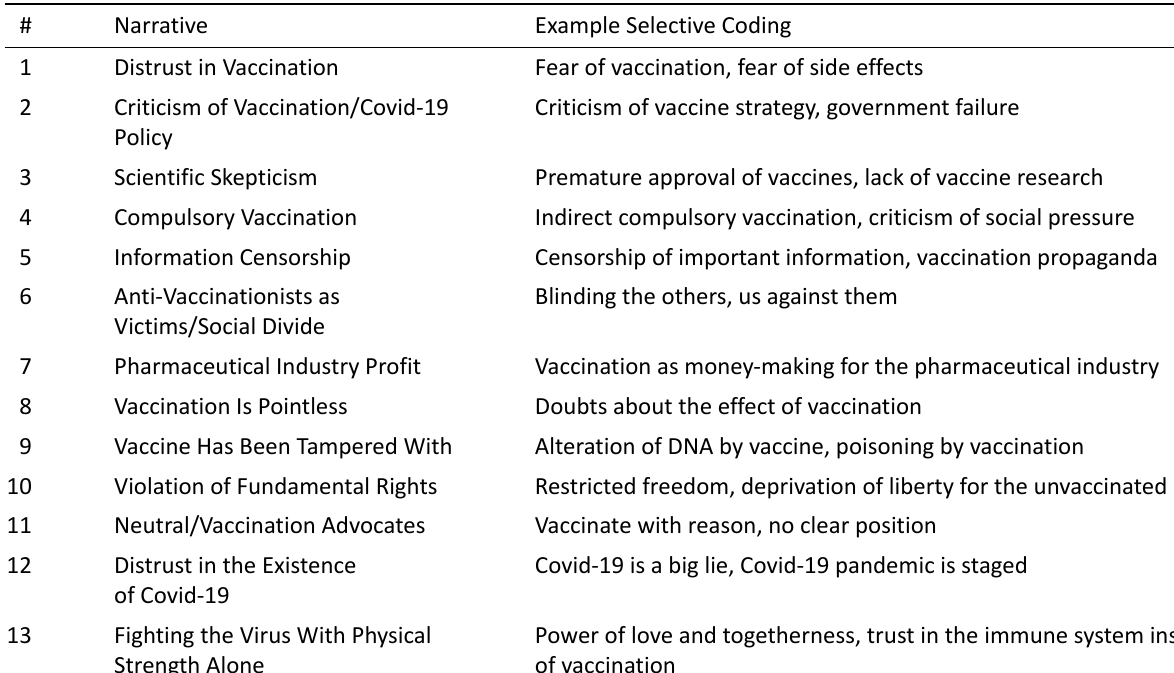
Table 2. German narratives and example selective